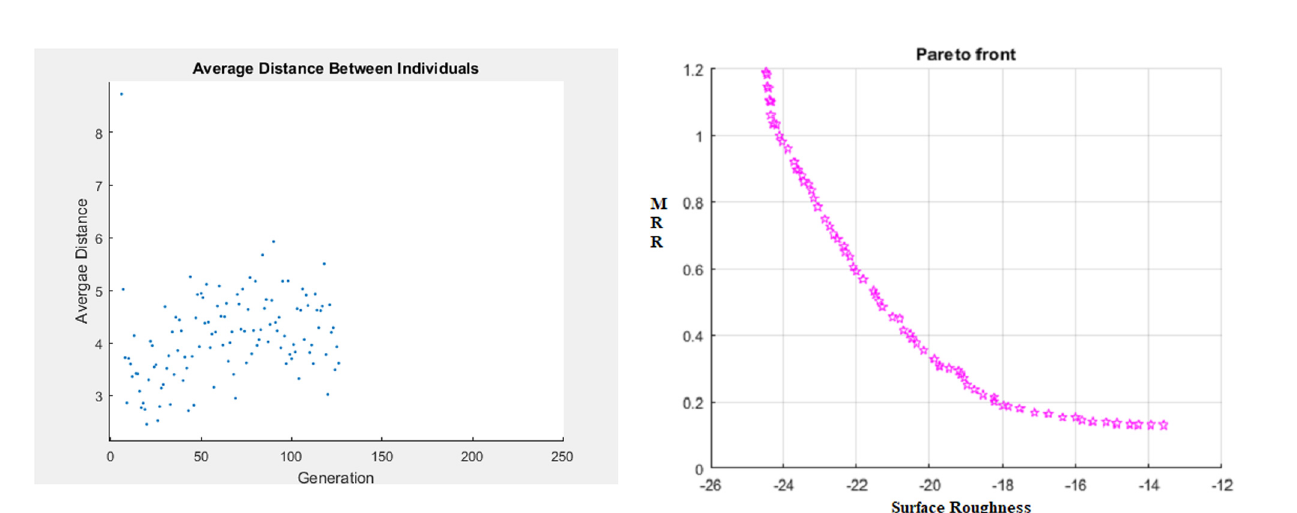
Figure 14: The initial solution set of 200